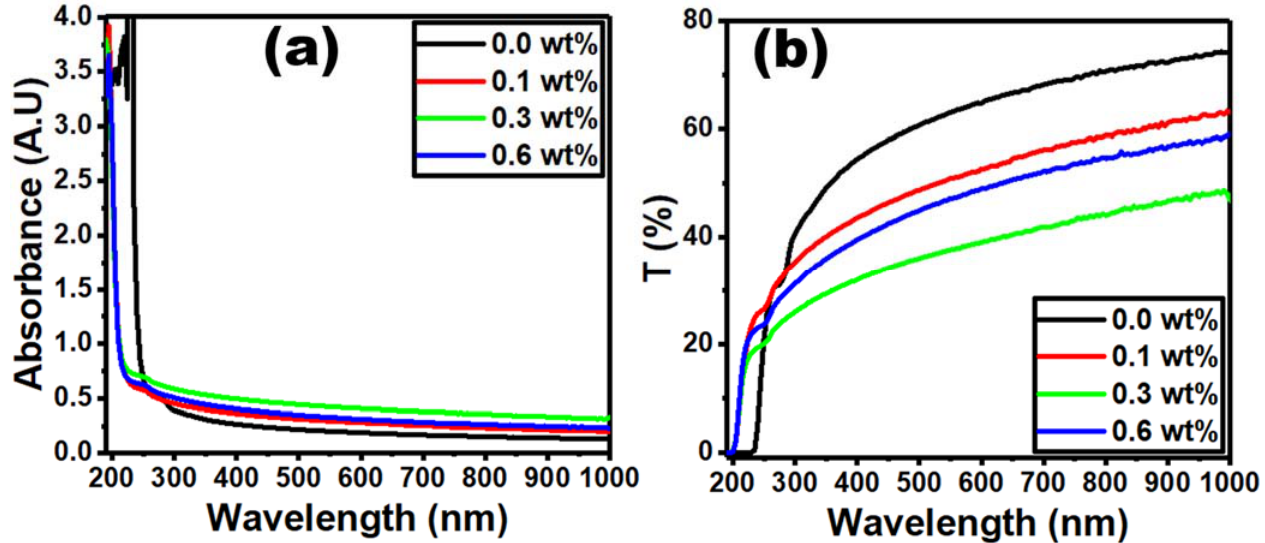
Figure 6. Plots of optical measurements for pure and doped PVC/PVP film with different Er 2 O 3 concentrations: ( a ) absorbance and ( b ) transmittance against wavelength.